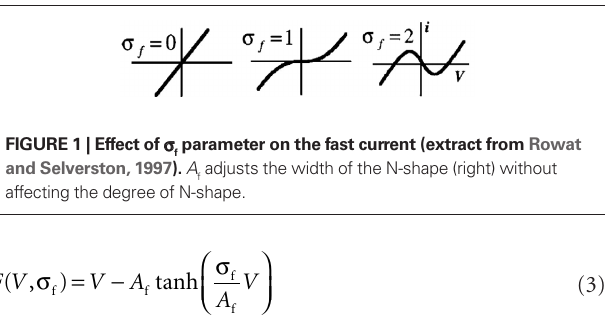
and σ . s f = 0.05 then σ = 2 s s or σ s f